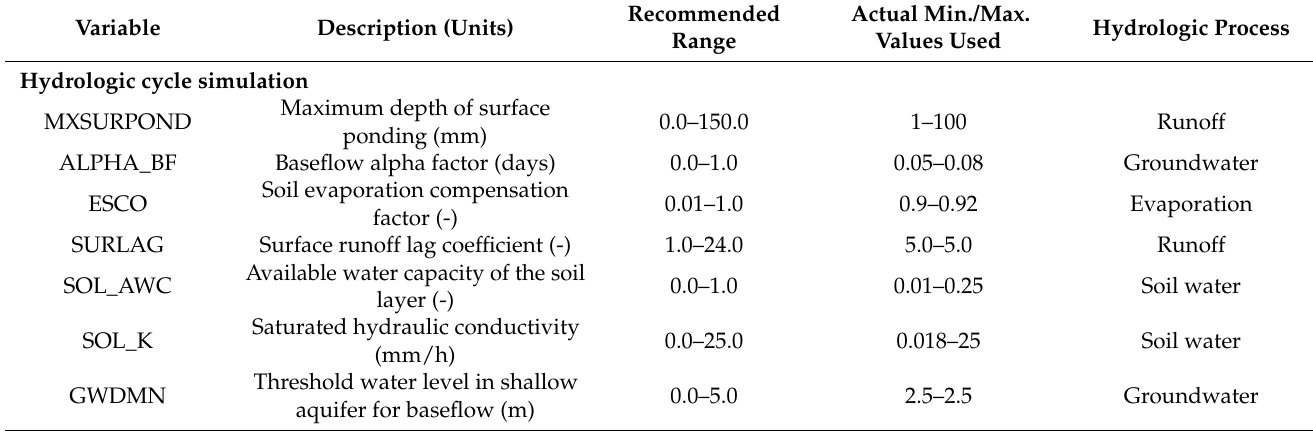
Table 1. Key parameters used for hydrologic cycle and groundwater simulations at the representative hydrologic stations and groundwater observation